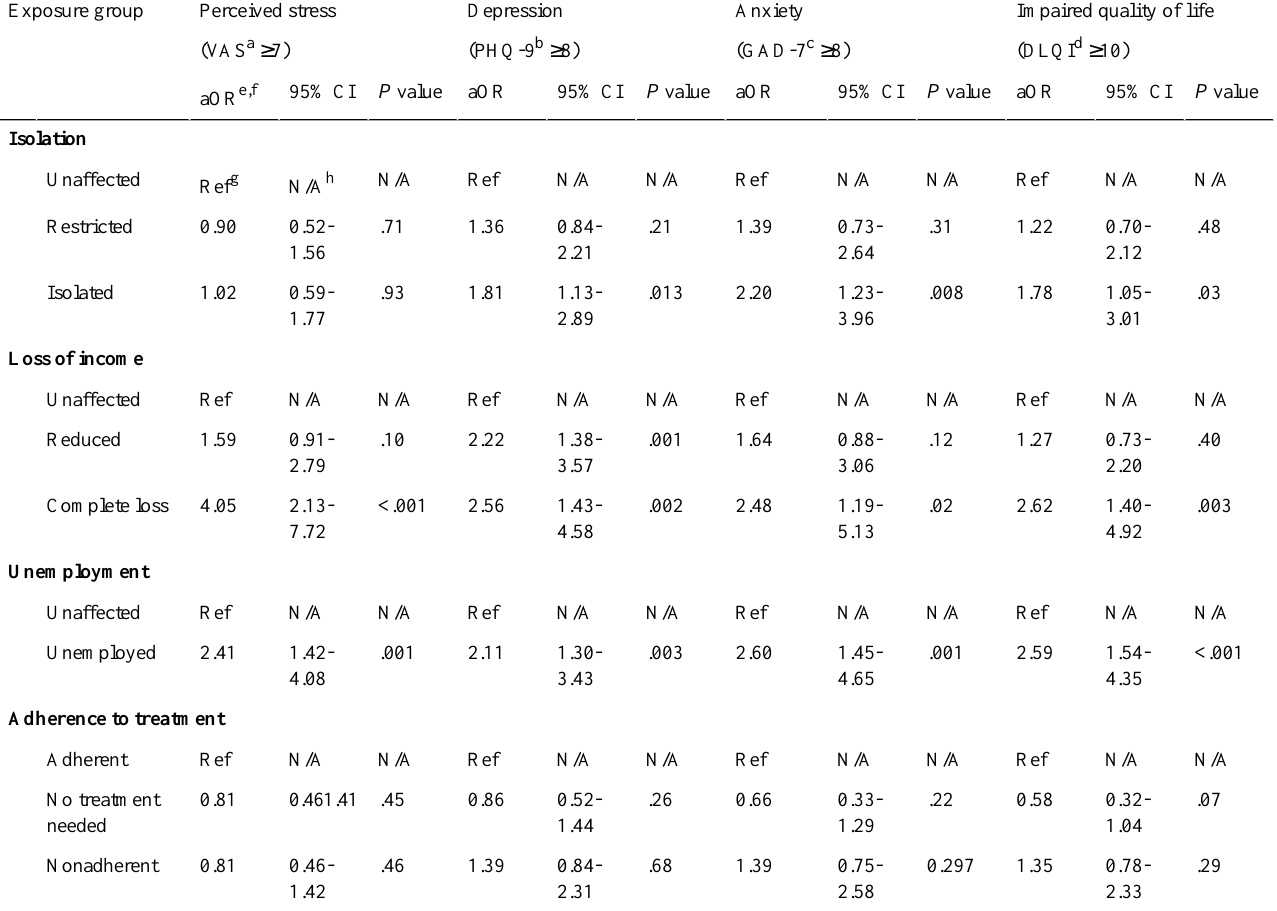
Table 3. Associations of epidemic-related impacts with patient-reported outcomes of skin diseases (N=506).